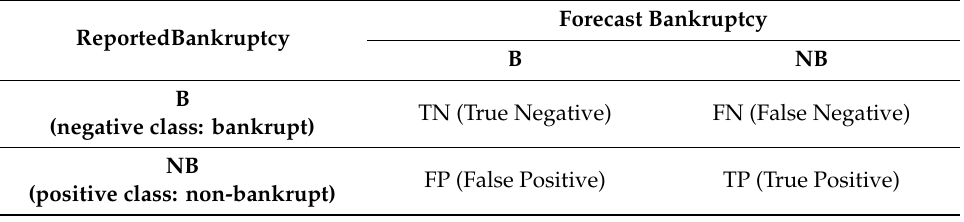
Table 2. Confusion matrix for the validation of classification consistency of the bankruptcy